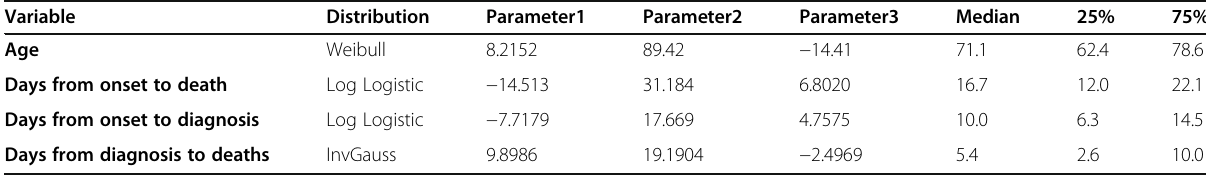
Table 2 Distributional fits to key COVID-19 distributions